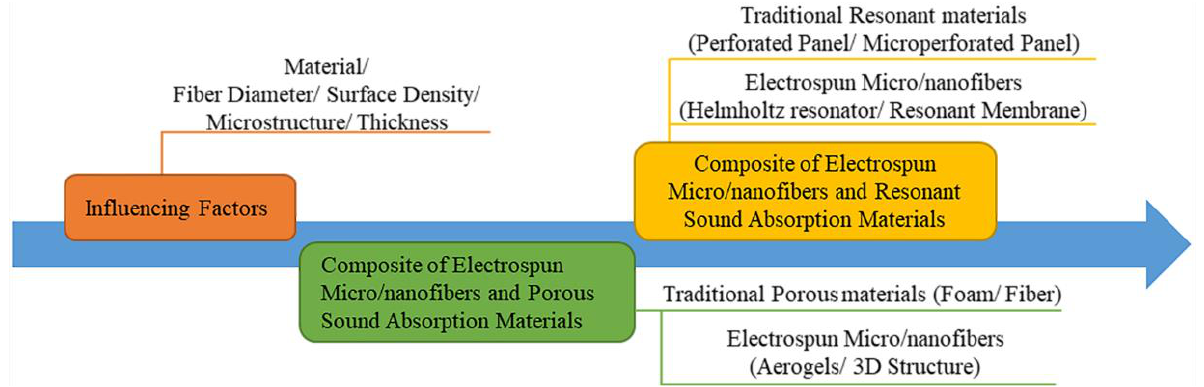
Figure 1. The outline map of this review.